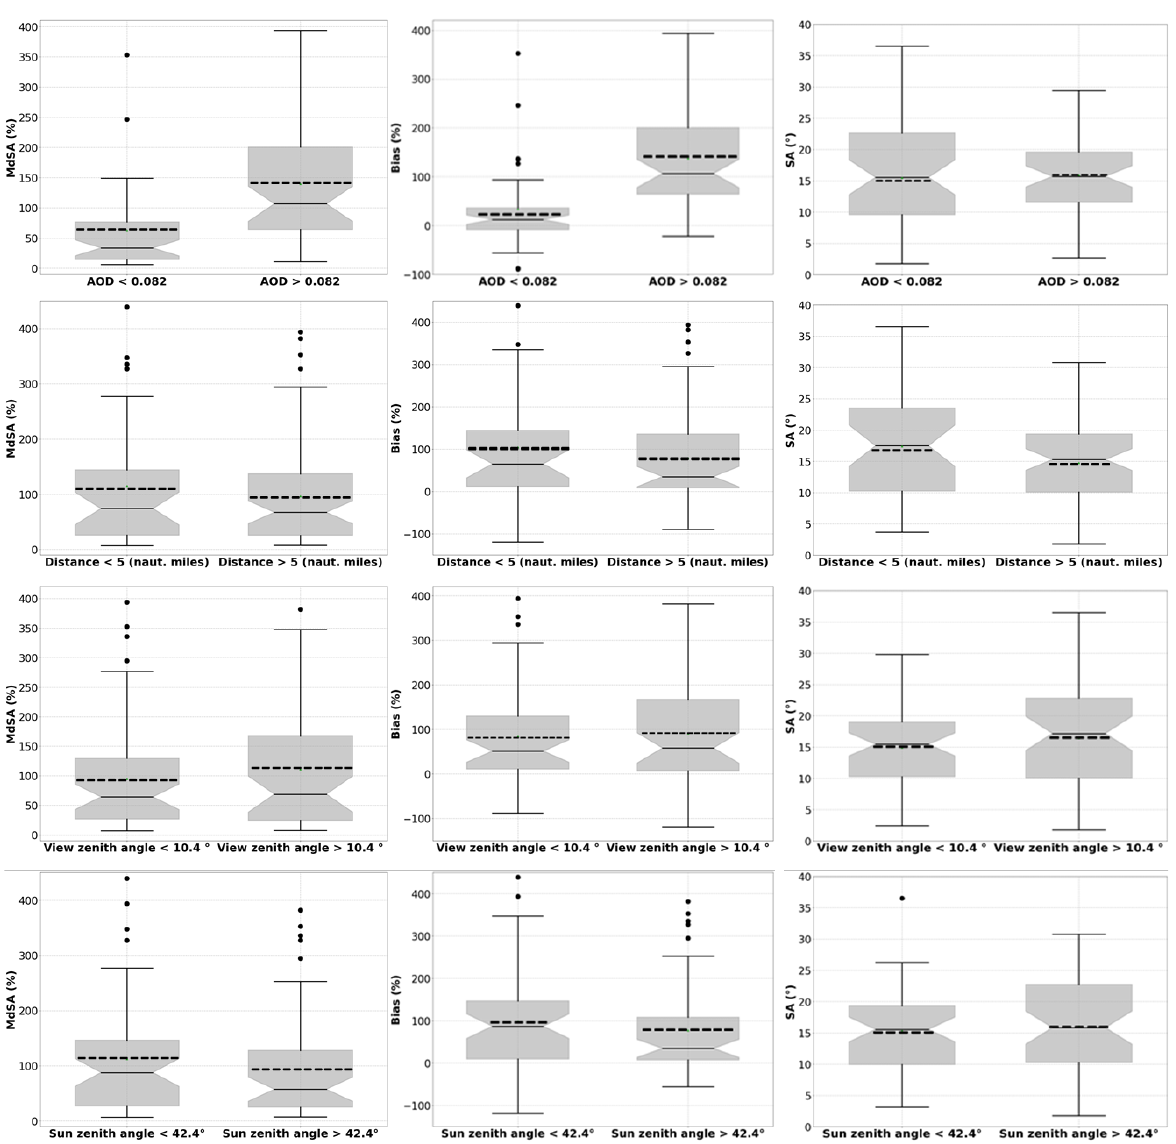
Figure 8. Box plots referring to the AOD (0.082 represents the median value), view zenith angle (10.4° represents the median value), sun zenith angle (42.4° represents the median value) and Distance from the coastline (5 nautical miles represent a threshold value in accordance with [49]). The continuous line represents the median while the dashed line represents the